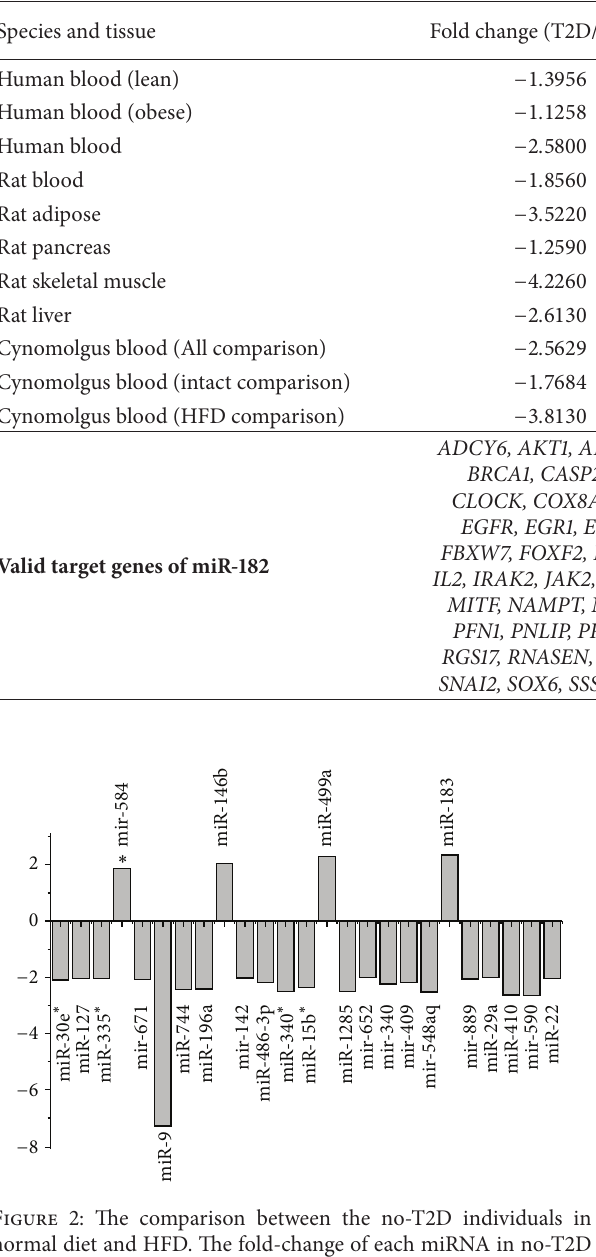
Table 2: The details of the differential expressed miR-182 in the T2D individuals.